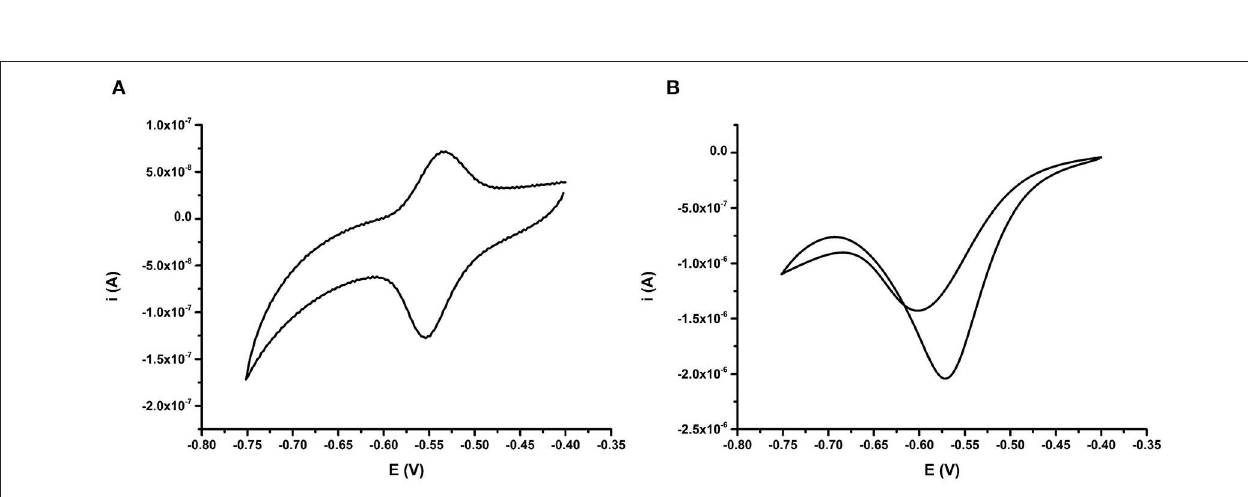
Frontiers in Chemistry |